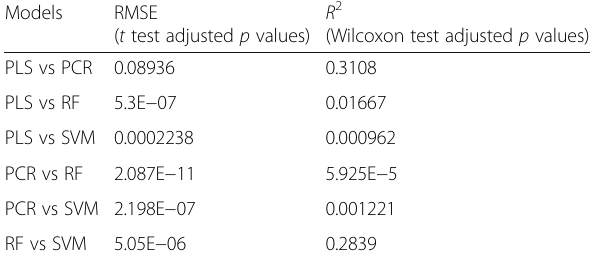
Table 7 Results of pairwise comparisons between methods